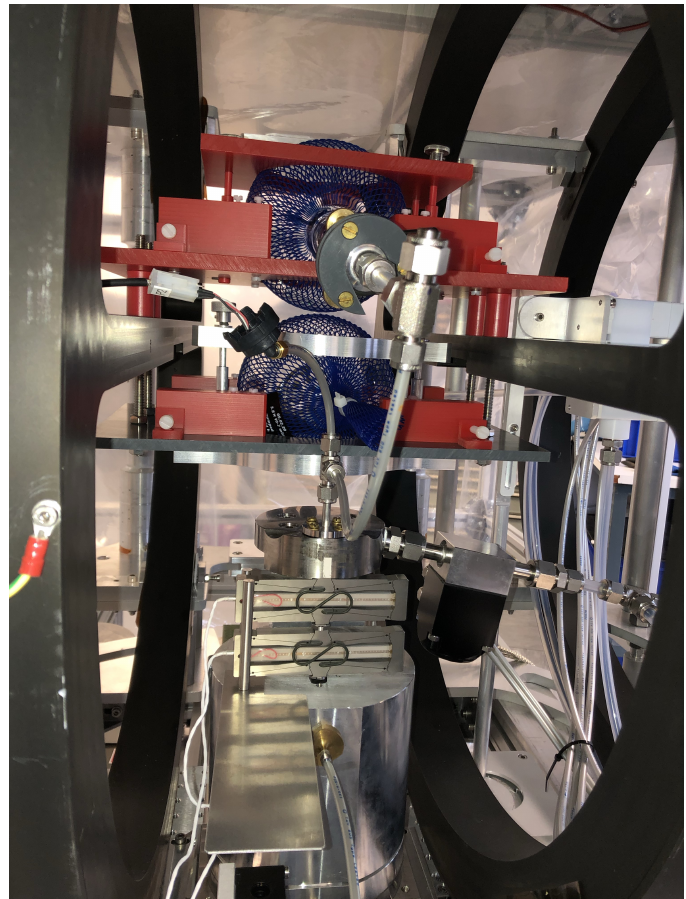
Figure 20. Test with polarized 3 He. The input vessel with 3 bar is the lower one and the collection glass ball